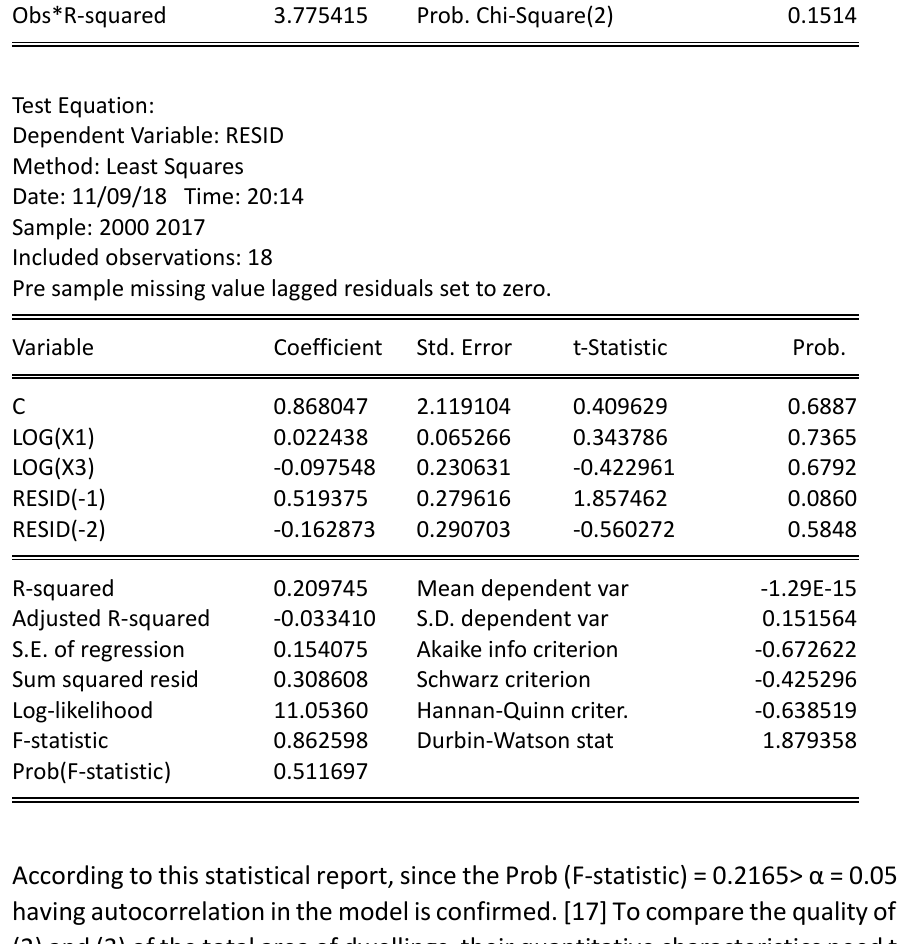
Table 7 “Breusch-Godfrey” Serial Correlation LM Test